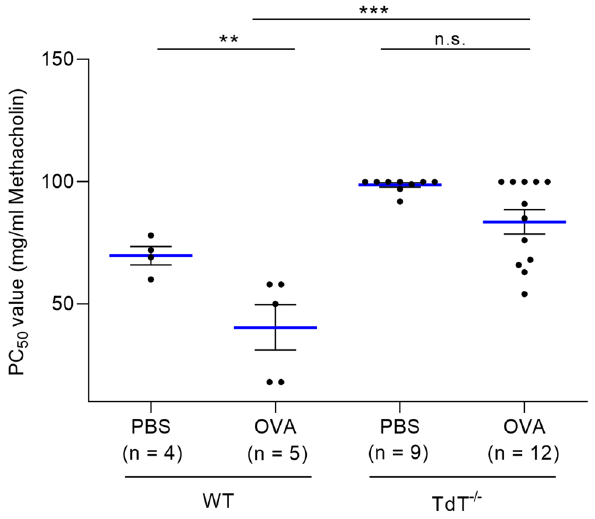
Figure 4. Lung function analysis—methacholine response. Head-out body plethysmography was used to assess lung function on day 29. Methacholine provocation was performed in the headout body plethysmograph to evaluate airway responsiveness. The PC 50 value represents the provocation concentration of methacholine required to induce significant airway obstruction. In wt animals, PC 50 was significantly reduced in the group of OVA-sensitized and challenged mice compared to the PBS control (p < 0.01). In TdT −/− mice, no